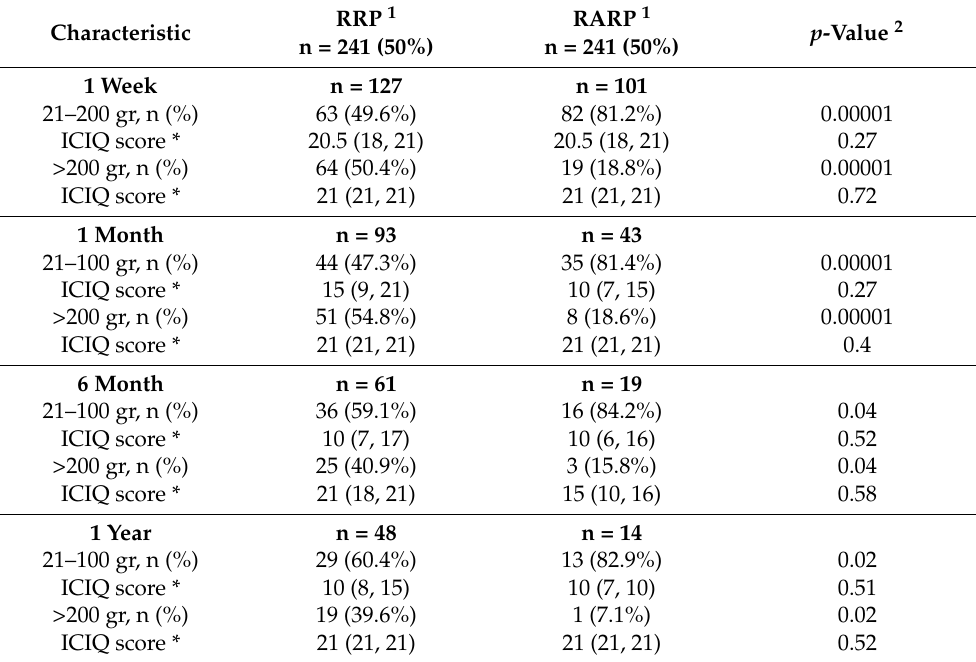
Table 3. Incontinence recovery rates (pad > 20 gr) in patients undergoing RRP and RARP at 1 week, 1 month, 6 month, and 1-year